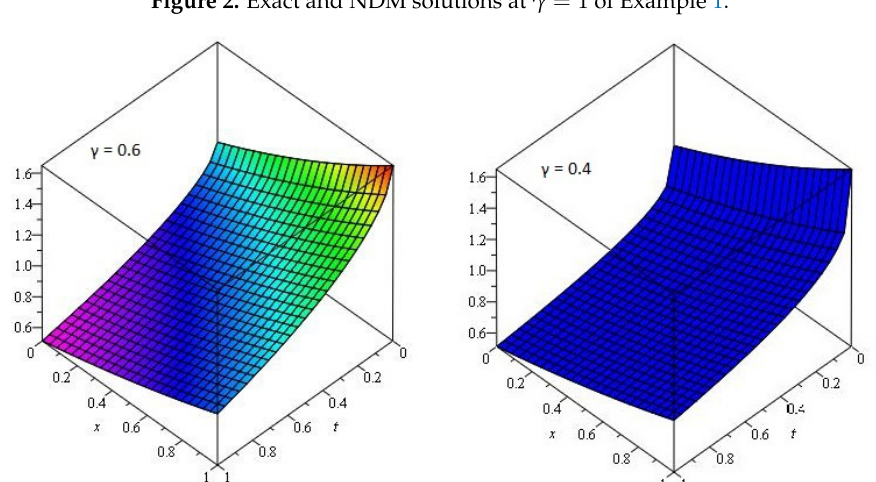
Figure 3. The NDM solutions of different valve of γ of Example 1.